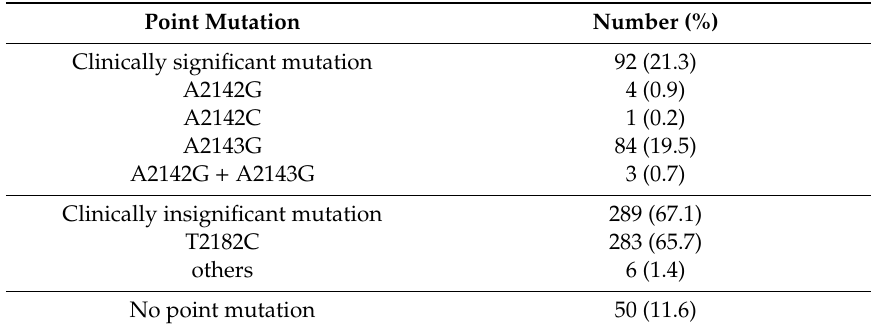
Table 2. Distribution of clarithromycin resistance-related point mutations determined through sequencing ( n = 431).